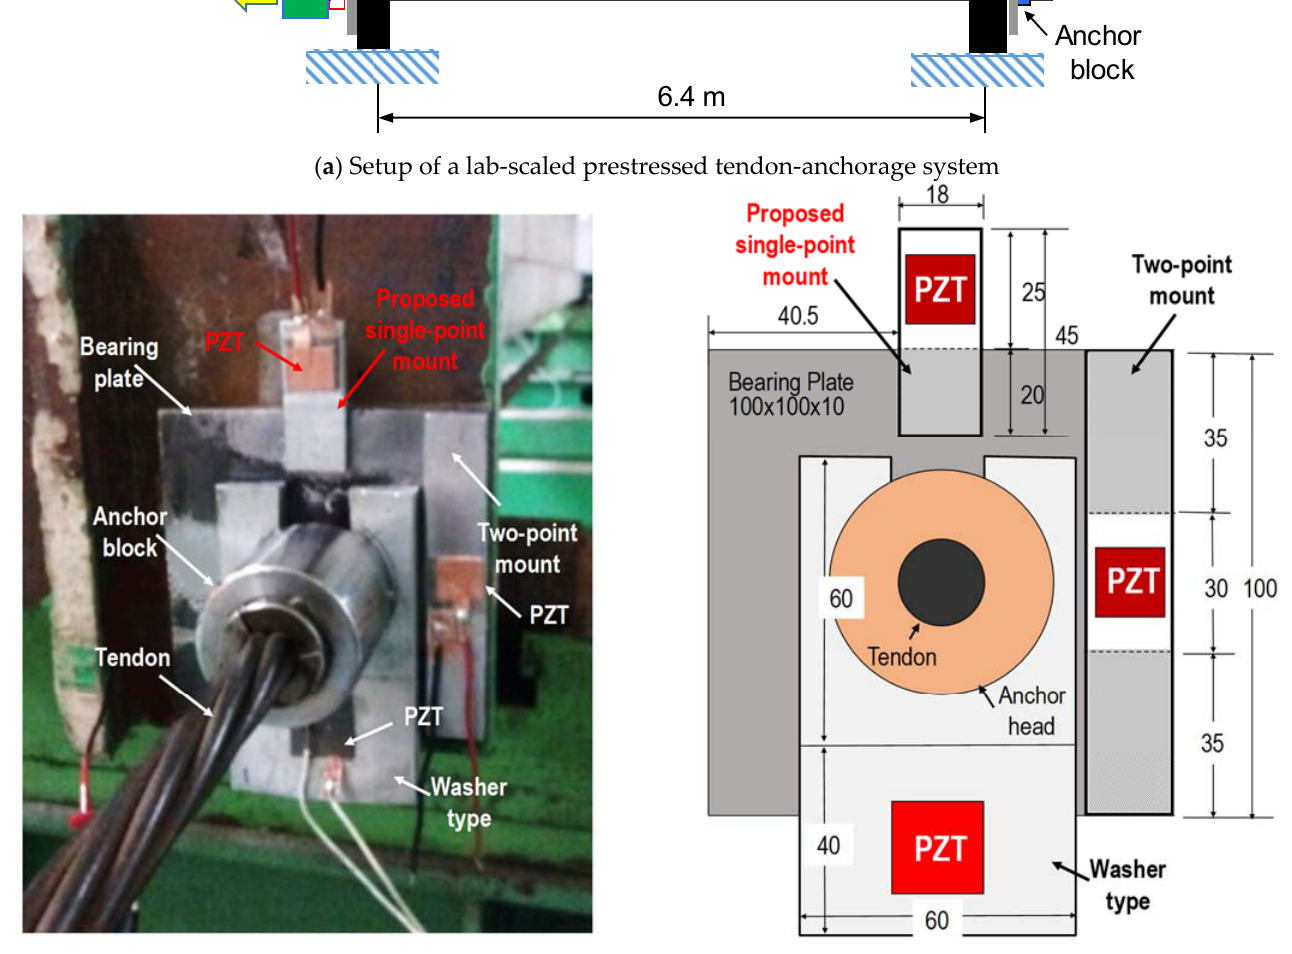
Figure 8. Setup of the lab-scaled prestressed anchorage.